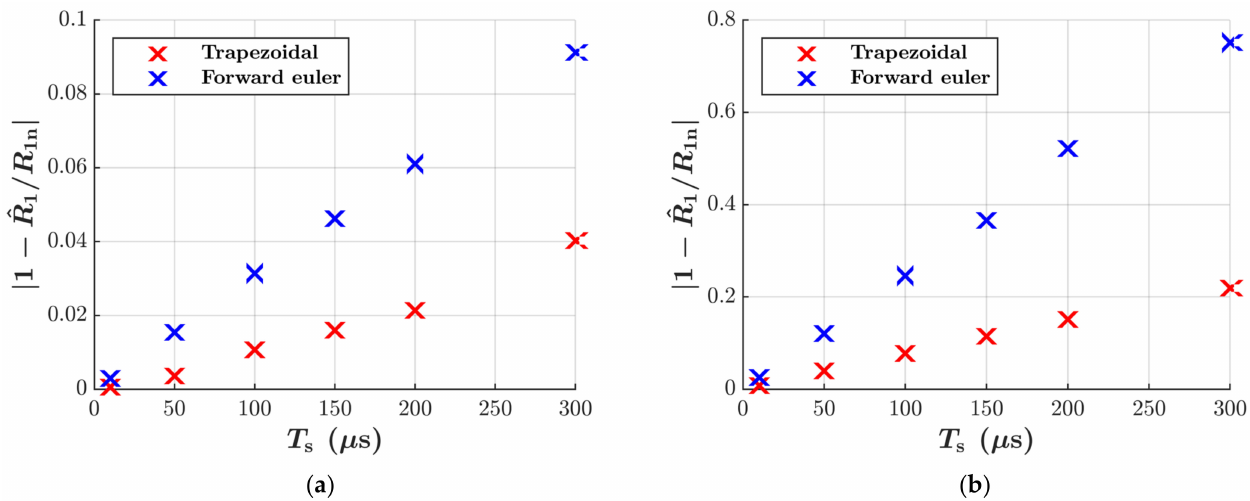
Figure 11. The effect of discretization and sampling time T s on P-MRAS accuracy at different operating points. ( a ) 20% of the nominal speed and 50% of the nominal torque; ( b ) 80% of the nominal speed and 50% of the nominal torque.